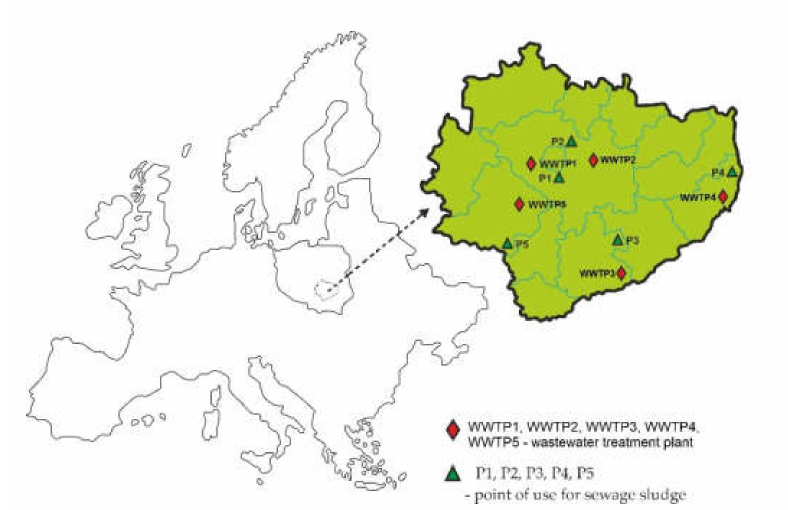
Figure 1. Location of wastewater treatment plants (own research) and potential sites of agricultural use of sewage sludge. Table 2. Characteristics of analyzed sites of potential sewage sludge utilization [38–40].